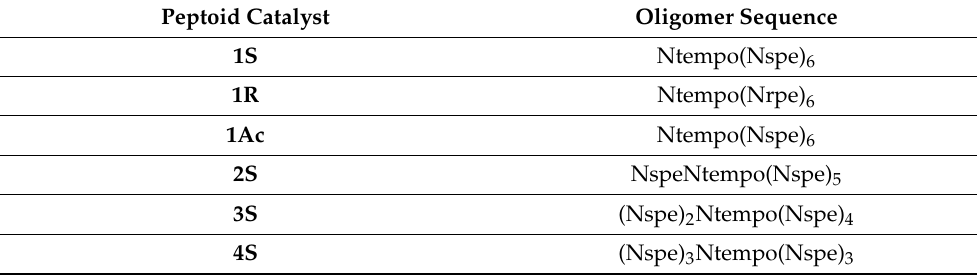
Scheme 1. Preparation of peptoid oligomers 1 – 9 . Table 1. Oligomer sequence of catalysts.